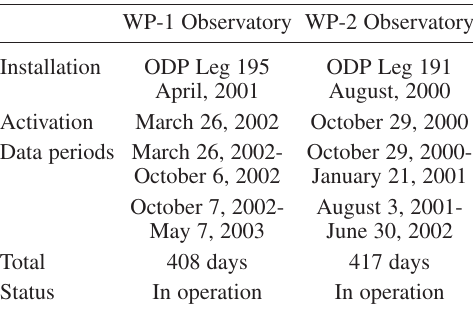
Fig. 6. Installation of the titanium sphere contain- ing the data recorder and the lithium batteries as backup at the top of the platform for long-term ob- servation for the WP-2 station (August 5, 2001). The power is mainly supplied from the Sea Water Battery system. The SWB system has four SWB1200 cells. The cell is a magnesium and oxygen battery based on a magnesium anode that uses seawater as the elec- trolyte. When voltage from the SWB is dropped, the lithium batteries in the sphere supply backup Table I. Summary of observation period of the WP- 1 and WP-2 observatories.